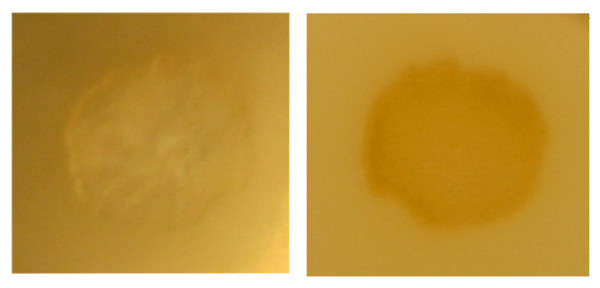
Photowhitening and photodarkening. Close-up photographs showing the white (left) and brown (right) lesions produced by irradiation with a 355 nm pulsed laser. The lesions are circular with a diameter of 1.4 mm, corresponding to the aperture used.